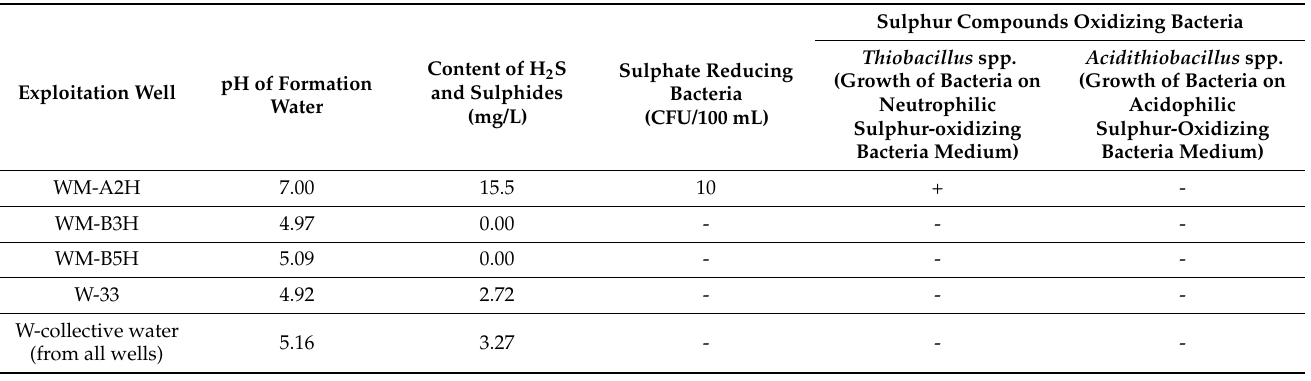
Table 3. The results of microbiological and chemical tests on formation waters collected from Wierzchowice UGS wells— XVIII operational cycle (2013/2014).